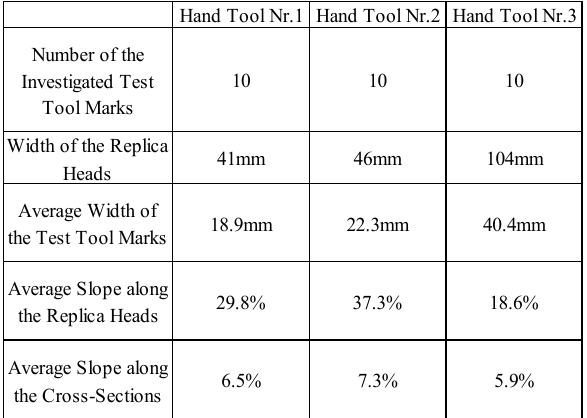
Table 1. The evaluation of the width and slope values After this step, the average width parameters of the test tool marks were applied to define a second slope value for the heads of the adzes. The polylines of the complete cutting edges were intersected by these calculated width parameters of the hand tool impressions and the new angles were determined between the horizontal lines and the both intersection points (Figure 4).